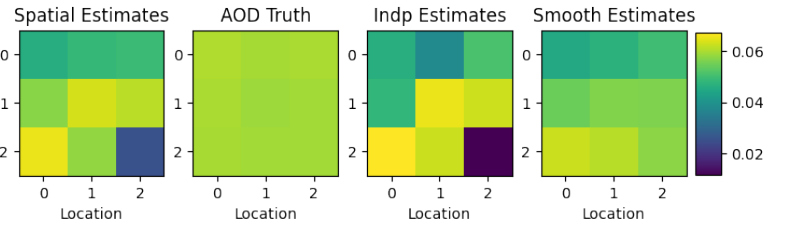
Figure 3. Inversions of simulated data showing the aerosol optical depth estimates across 9 pixels on a 3 × 3 grid. The spatial prior is more accurate than the independent inversions and comparable to post-hoc smoothing.